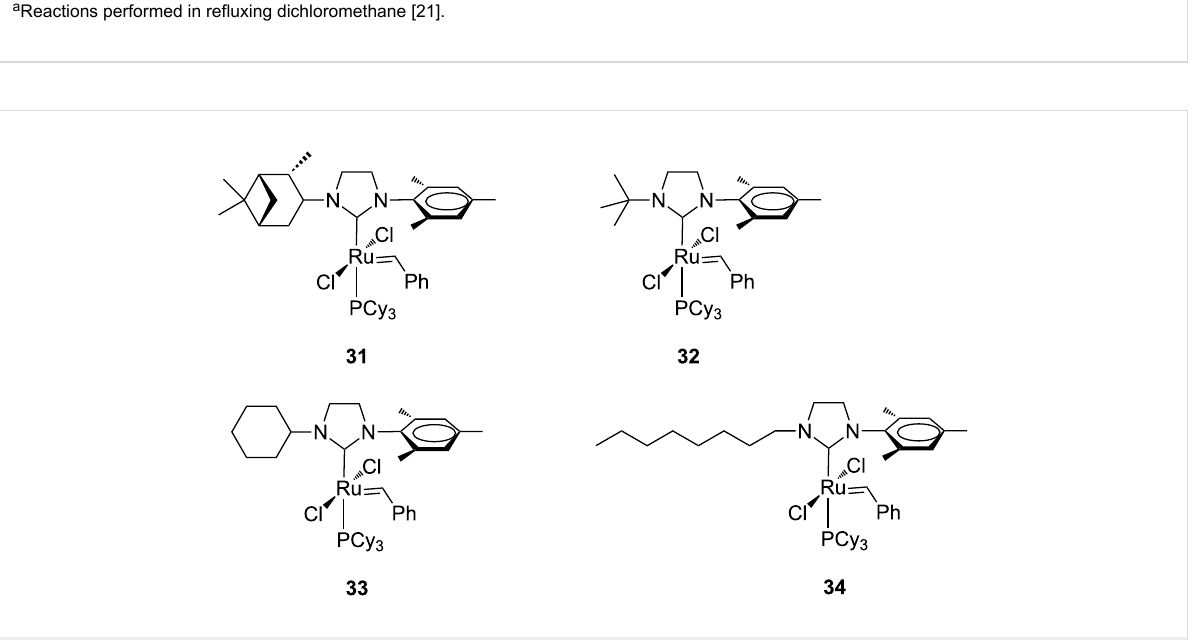
Figure 8: Grubbs-type complexes 31 – 34 with N -alkyl, N’- mesityl NHCs.